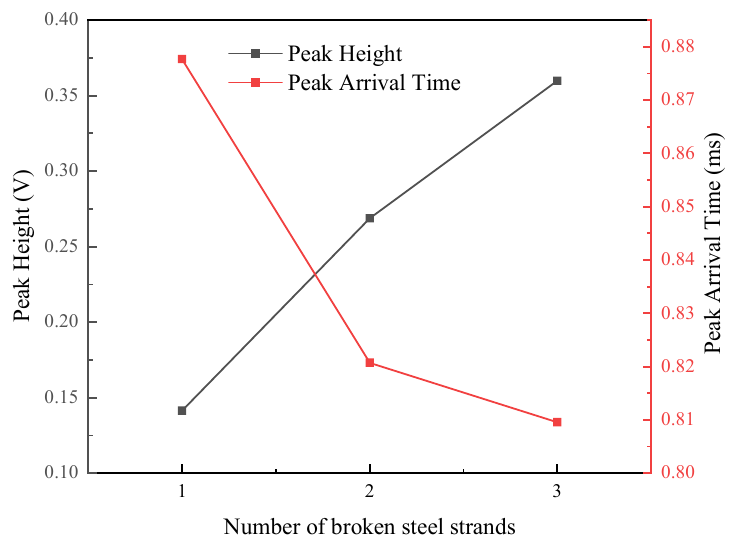
Figure 12. Relationship between the peak value, the peak arrival time, and the different broken steel strands.